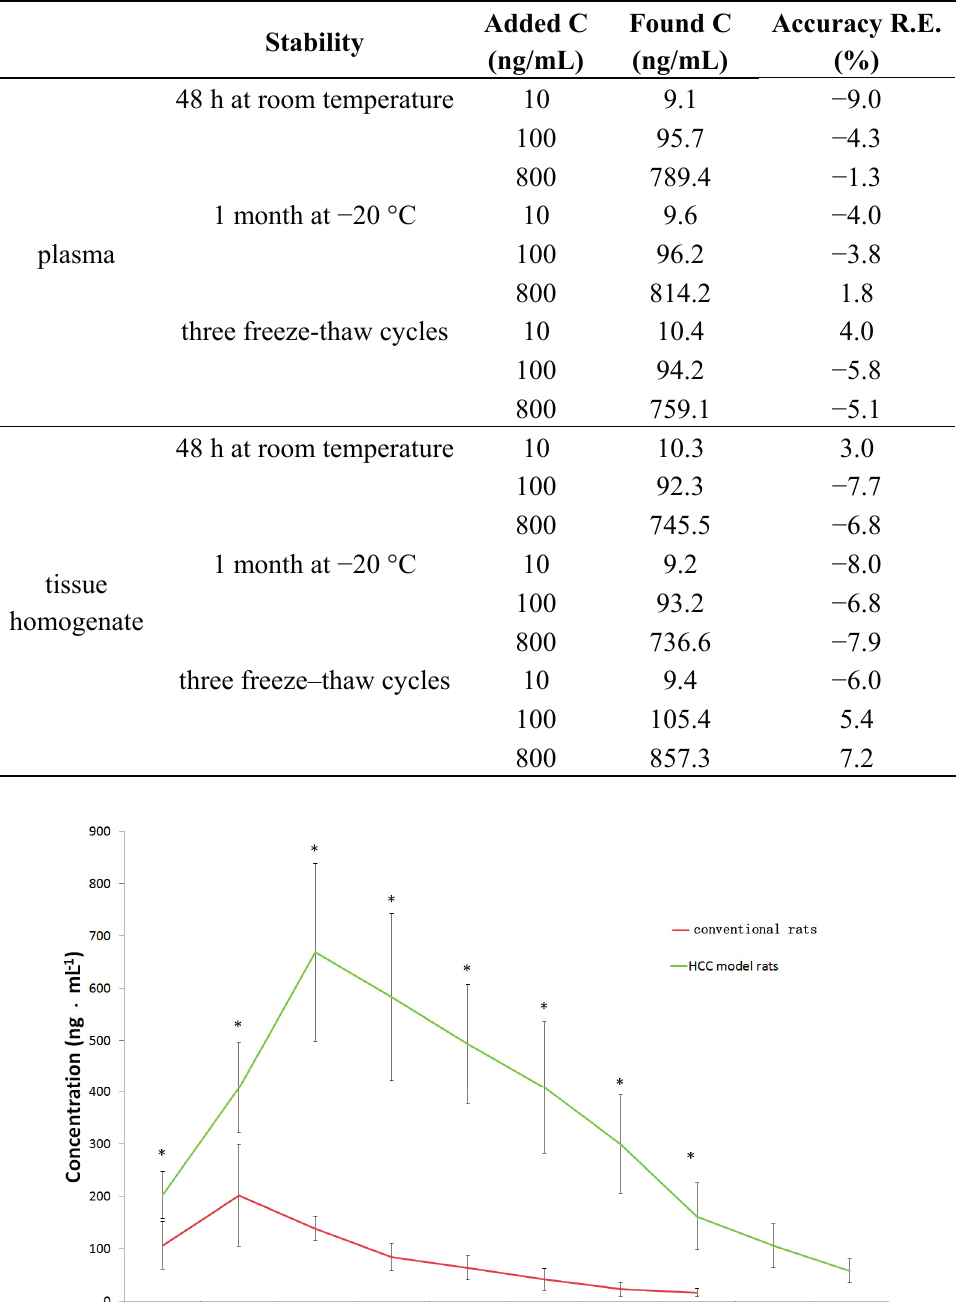
Table 2. Stability of caudatin in rat plasma and tissue homogenate (n = 5).